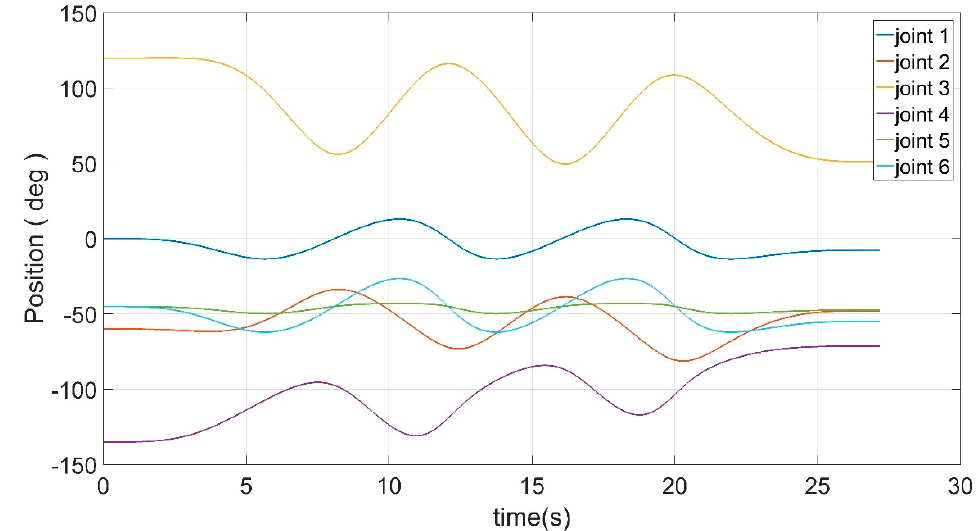
Figure 19. The joint trajectory after the inverse kinematics solution.